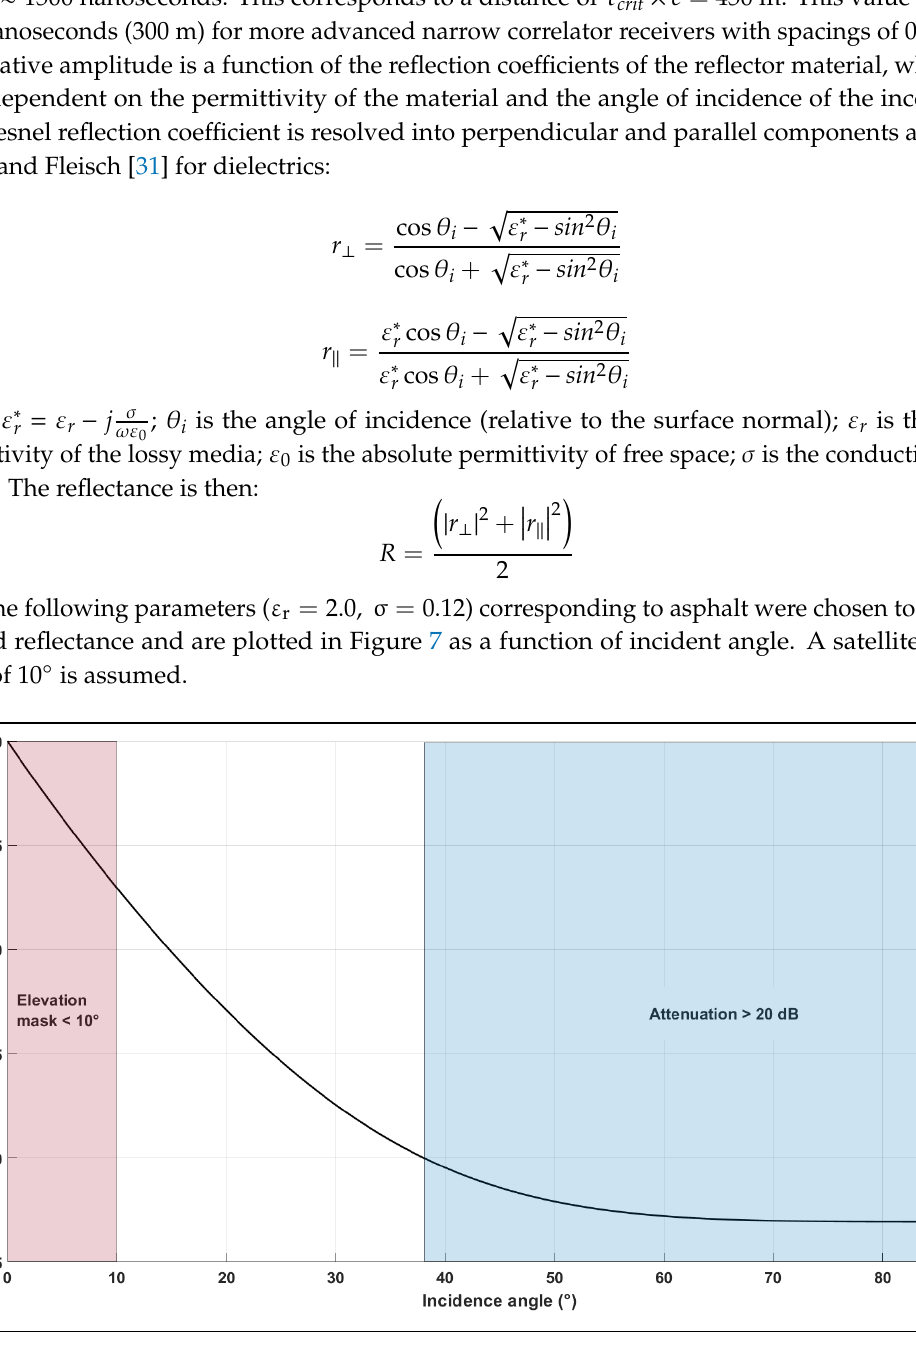
Figure 7. Ground reflectance region.